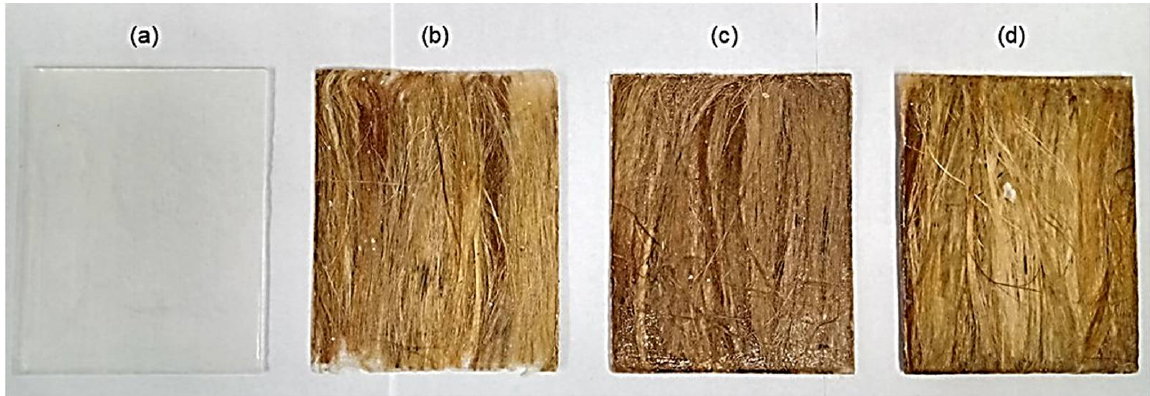
Figure 3. Plates produced: ( a ) 0; ( b ) 10 vol%; ( c ) 20 vol% and ( d ) 30 vol% kenaf fibers.